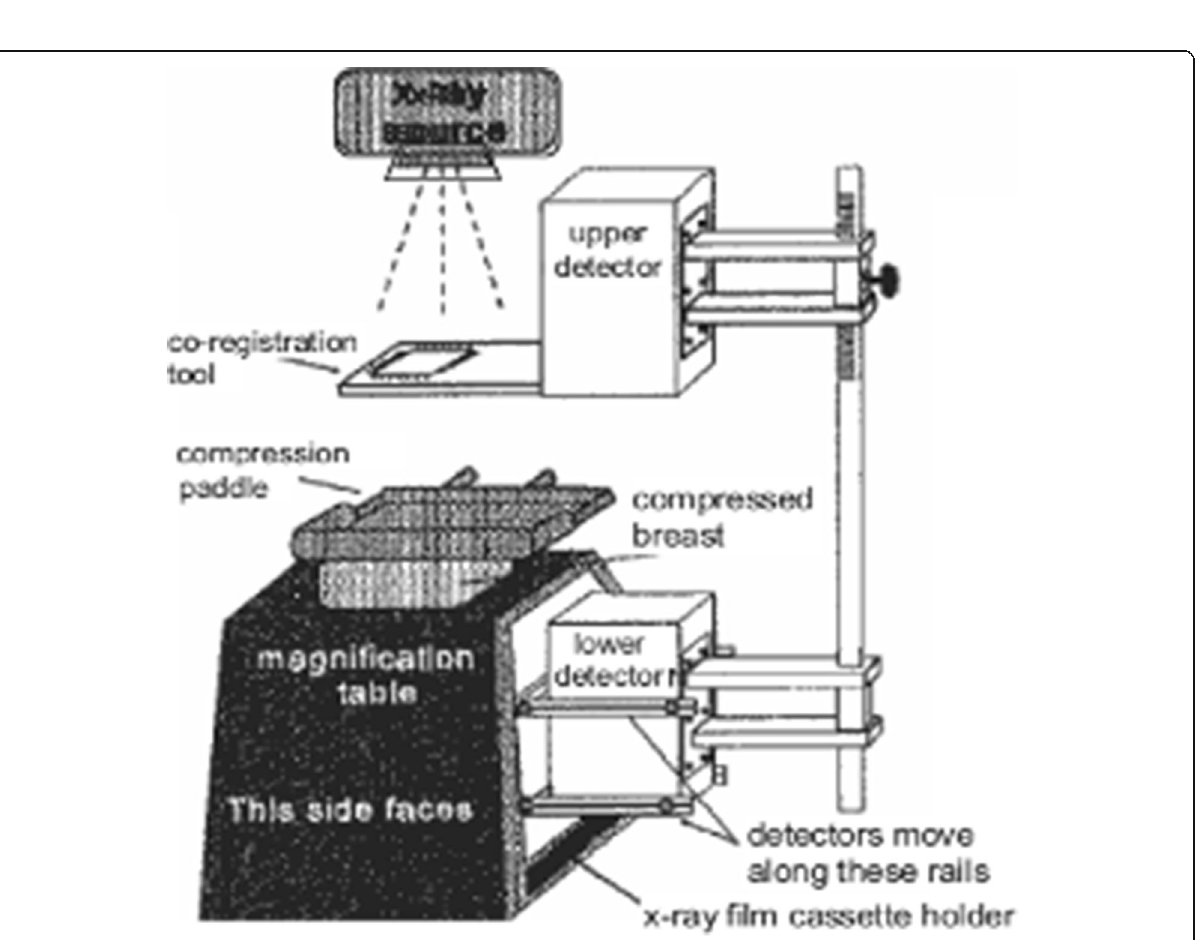
Fig. 18 A view of PEM detectors installed on conventional mammography